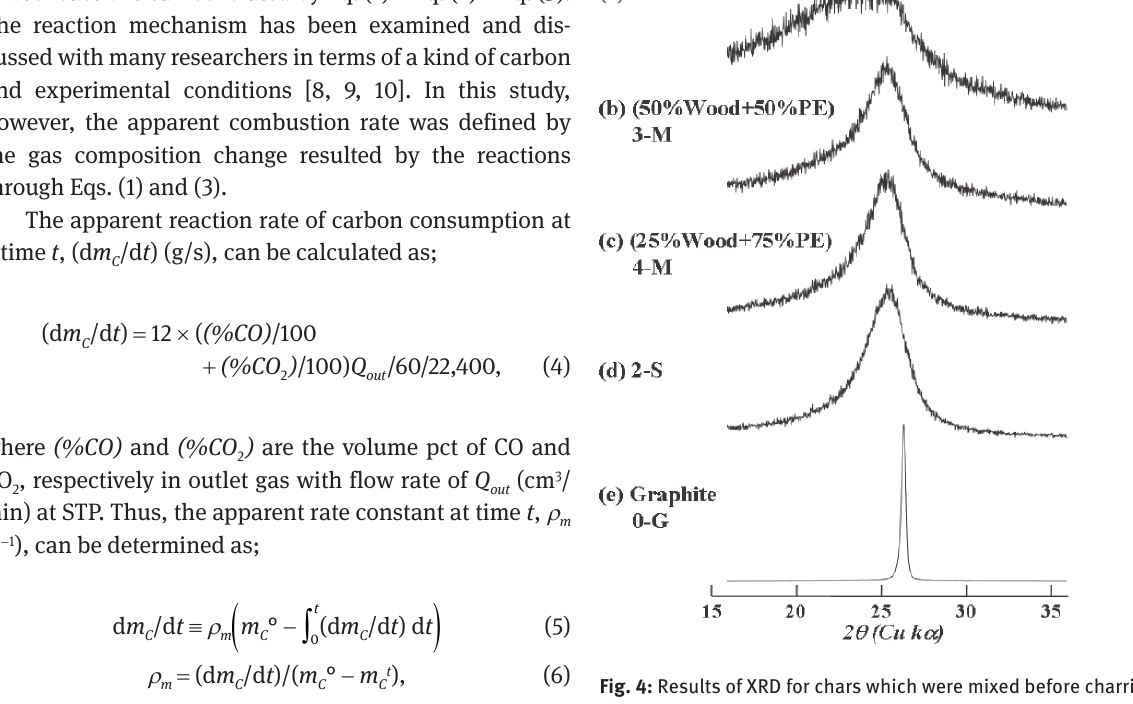
Fig. 4: Results of XRD for chars which were mixed before charring in comparison with single chars and graphite.